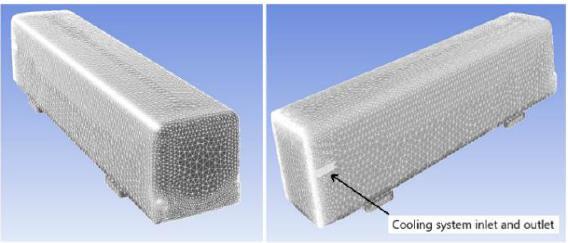
Fig. 5. A discrete model of an electric vehicle (bus)